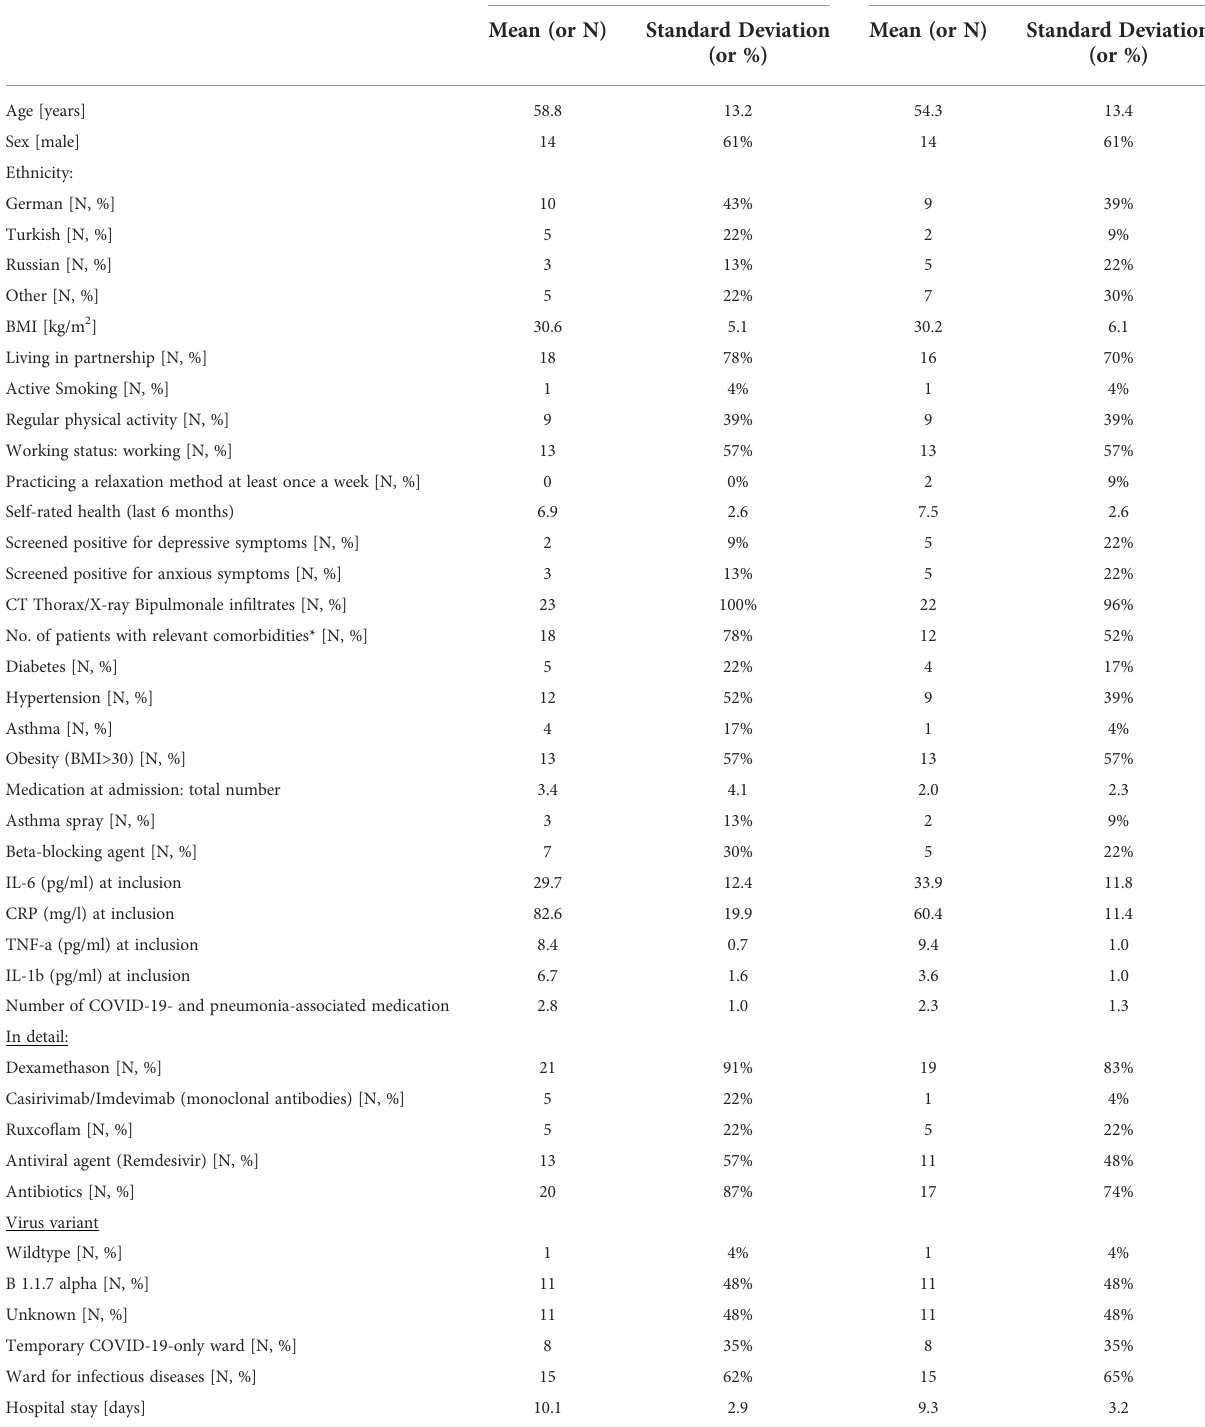
TABLE 1 Characteristics of the patients at baseline according to treatment